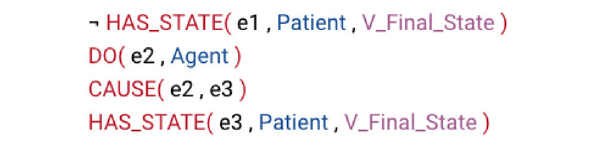
FIGURE 3 | Semantics representations of the Carry-11.4